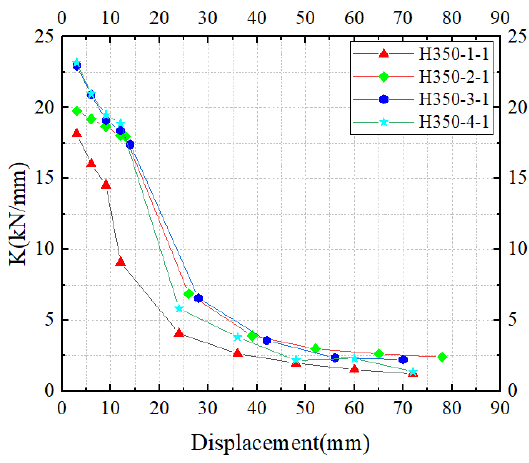
Figure 15. Stiffness degradation curves.